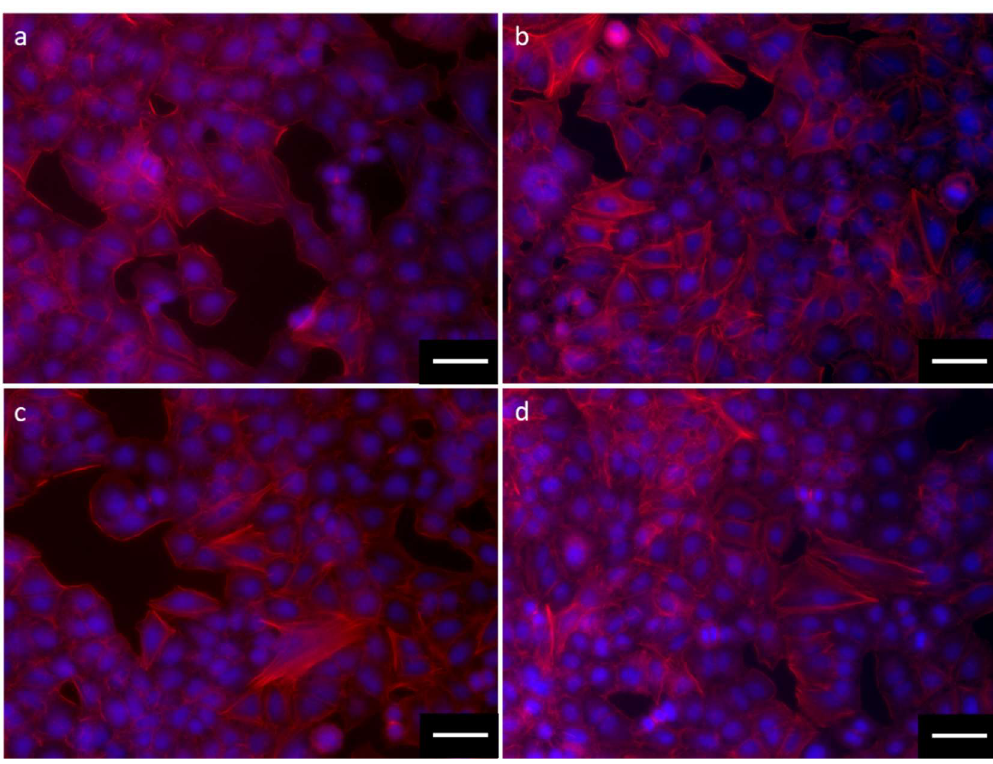
Figure 9. Morphology of cells after exposure to 75 μg TiO 2 /mL of TiO 2 :SiO 2 NPs 1:1 ( b ), 1:3 ( c ), 3:1 ( d ). Control cells are shown in ( a ). Cells were fixed and stained with DAPI (blue) and Rhodamine Phalloidin (red). Scale bars: 50 μm.